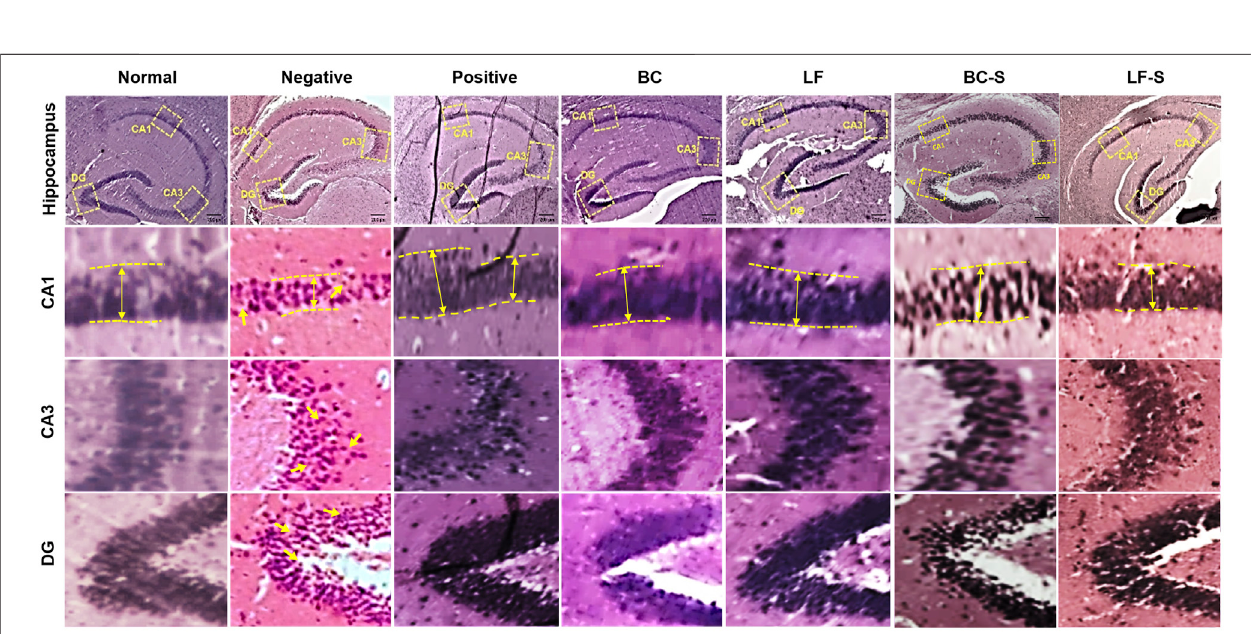
Frontiers in Pharmacology |